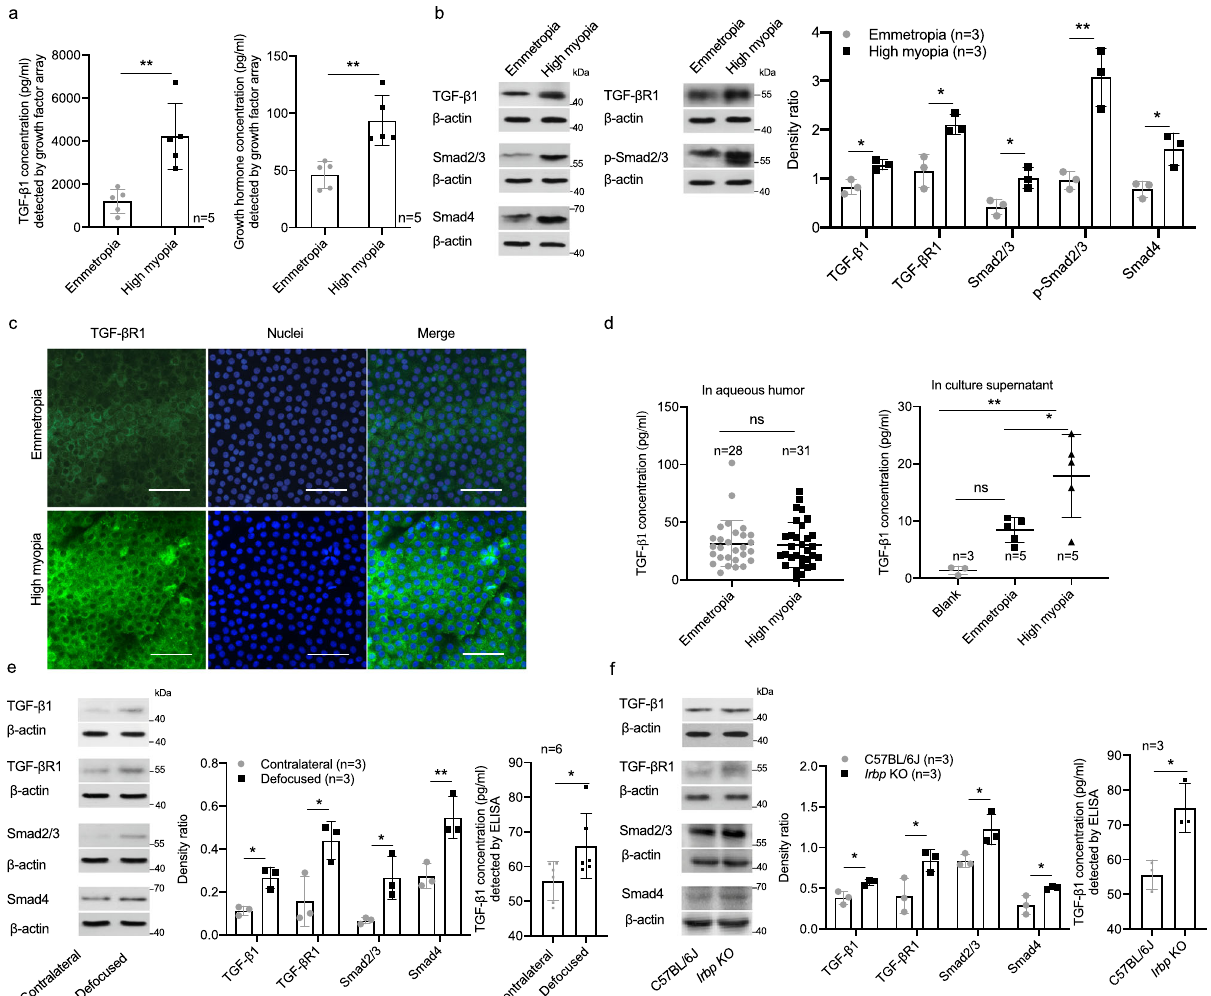
Fig. 6 Aberrant activation of TGF- β 1-Smads signaling in lens of high myopia. a Detection of TGF- β 1 and growth hormone levels in human lens epithelium by growth factor array ( n = 5, both p = 0.003). b Examination of protein expression by Western blotting of TGF- β 1, TGF- β R1, and downstream Smad2/3, p- Smad2/3, and Smad4 ( n = 3, p = 0.012, p = 0.013, p = 0.019, p = 0.004, and p = 0.019, respectively). Right, the band density in Western blotting was normalized to loading control as a ratio for statistical analysis. c Immuno fl uorescence images of TGF- β R1 staining in human lens epithelium ( n = 5). Scale bar: 50 μ m. d Measurement of human TGF- β 1 concentration with ELISA in aqueous humor ( n = 28 in the control group vs. n = 31 in the highly myopic group, p = 0.876) and primary lens epithelial cell culture supernatant (3, 5, and 5 different cultures in the blank, emmetropic control, and highly myopic group, respectively, one piece of lens epithelium in one culture for this assay, bland vs. emmetropia p = 0.164, emmetropia vs. high myopia p = 0.027, blank vs. high myopia p = 0.002). Blank refers to DMEM without culture of lens epithelium. e Western blotting of protein expression of TGF- β 1, TGF- β R1, Smad2/3, and Smad4 ( n = 3, p = 0.012, p = 0.041, p = 0.048 and p = 0.008, respectively) and ELISA test of TGF- β 1 level in mouse lens epithelium of defocus-induced highly myopic eye and the contralateral eye ( n = 6, p = 0.016). Middle, the band density in Western blotting was normalized to loading control as a ratio for statistical analysis. f Western blotting of protein expression of TGF- β 1, TGF- β R1, Smad2/3, and Smad4 ( n = 3, p = 0.021, p = 0.040, p = 0.032, and p = 0.033, respectively) and ELISA test of TGF- β 1 level in lens epithelium of Irbp KO mice and wild type C57BL/6J ( n = 3, p = 0.015). Middle, the band density in Western blotting was normalized to loading control as a ratio for statistical analysis. n = biological replicates. In ( a , b , e , and f ), pooled samples were used. Results are expressed as mean ± SD. Level of signi fi cance was detected using two-sided Student ’ s t test (Figs. a, b, and f) and two-sided paired t test (Fig. e). In ( d ), TGF- β 1 concentration in aqueous humor was analyzed using two-sided Student ’ s t test, while the concentration in culture supernatant was analyzed using one-way ANOVA with Turkey ’ s multiple comparisons test for further comparison between two groups. ** p < 0.01, * p < 0.05 and ns represents no signi fi cant difference. Source data are provided as a Source Data fi